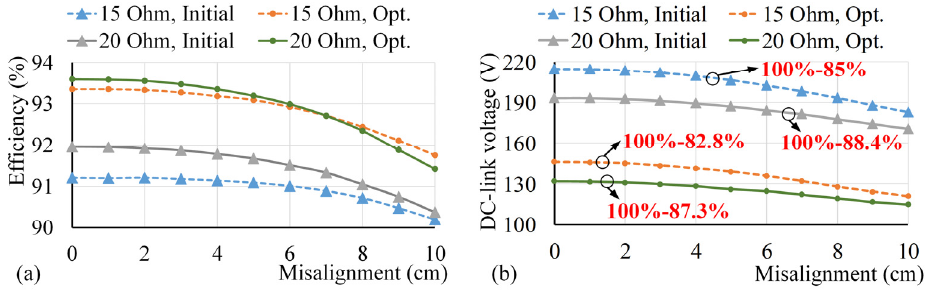
Figure 11. Experimental results. ( a ) DC-to-DC efficiency. ( b ) DC-link voltage.